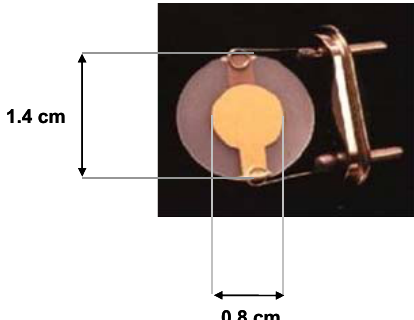
Figure 2. Illustration of the quartz used for the nanogravimetric acquisitions.